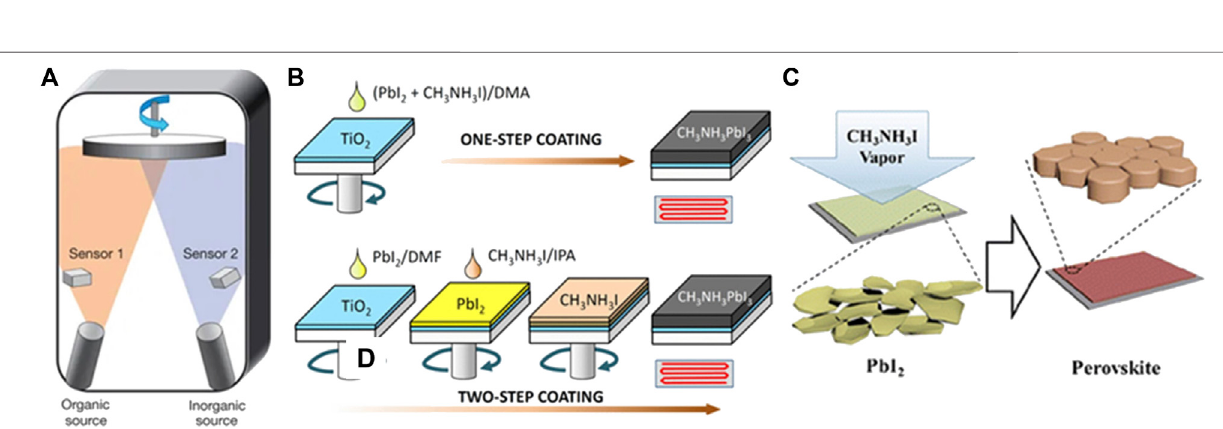
FIGURE 2 | (A) Cubic perovskite structure with ABX 3 . Adapted from Green et al. (2014) with permission from Nature springer. (B) UV-vis absorption spectra of PSCs with mixing halide ions and corresponding colorful fi lms. Adapted form Noh et al. (2013) with permission from American Chemical Society.